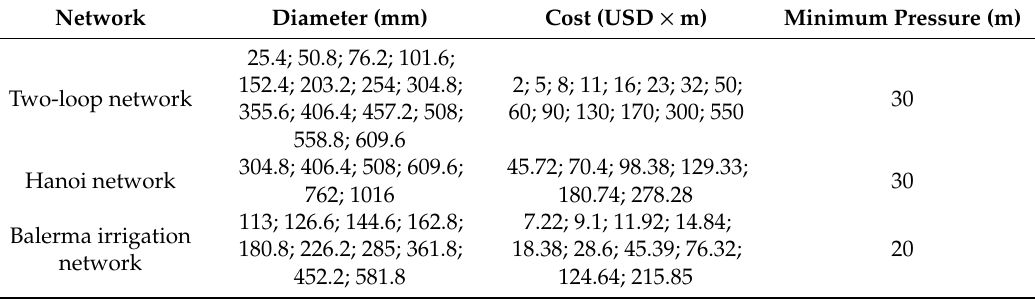
Table 4. Input parameters for the optimization